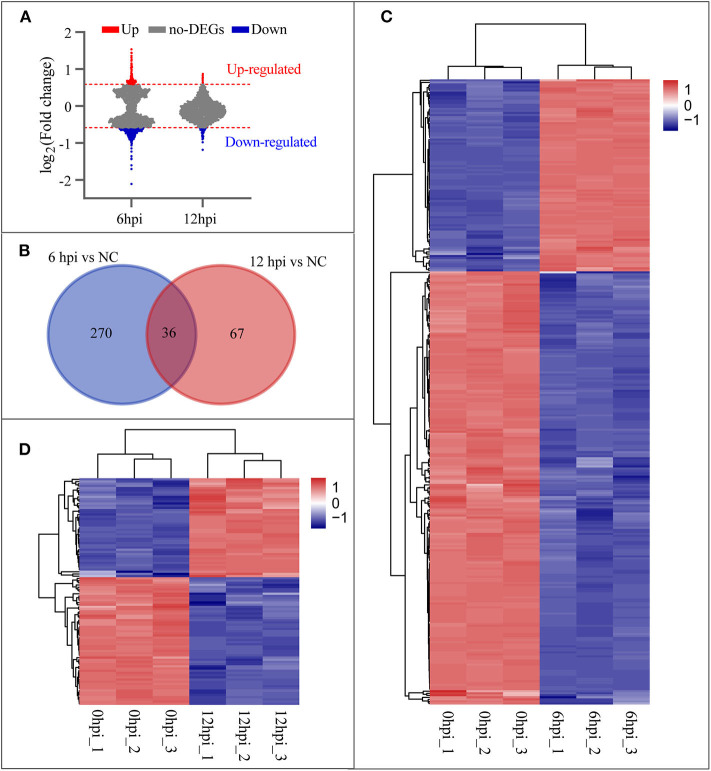
Differentially expressed genes (DEGs) at 6 and 12 hpi. (A) Changes of B. pseudomallei regulated cellular genes over time compared with NC (0 hpi) during the early stage of infection. Counts of genes up-regulated or down-regulated are shown in red or light blue dots, respectively, and a cut-off level of 1.5-fold change and a P-value < 0.05 were applied. (B) Venn diagrams depict the overlap of DEGs from each pairwise comparison between the time points, 6/0 hpi and 12/0 hpi. (C,D) Hierarchical clustering of DEGs at 6 and 12 hpi. Genes with high expression level are in red; genes with low expression level are in blue.